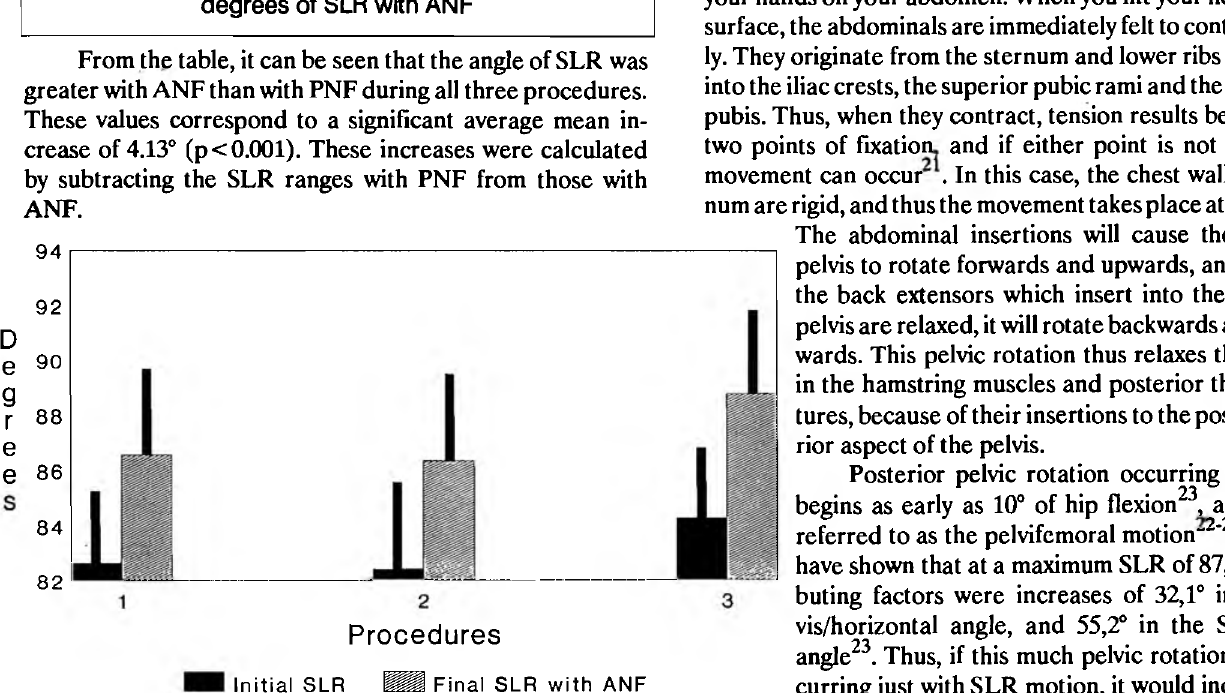
TABLE: Mean, standard error mean, t-value. degrees of freedom and probability for the increased range in degrees of SLR with ANF